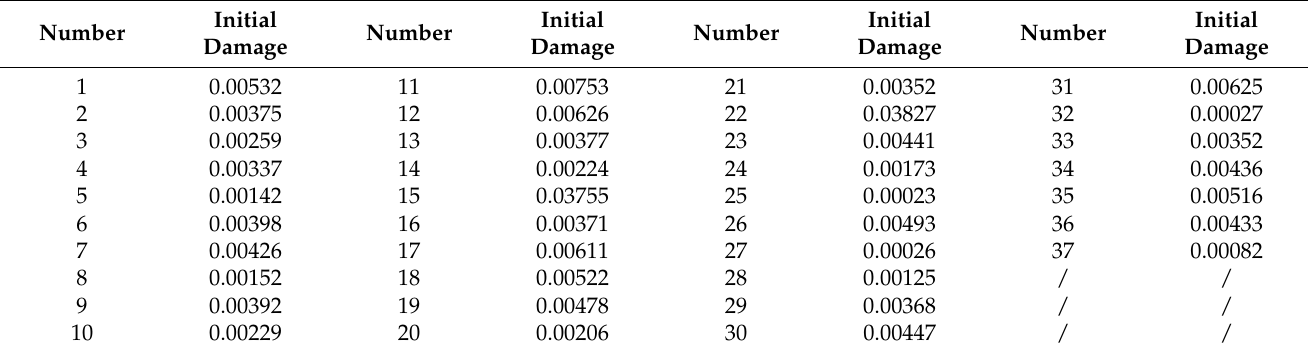
Table 1. The initial damage of the steel strand of the stay